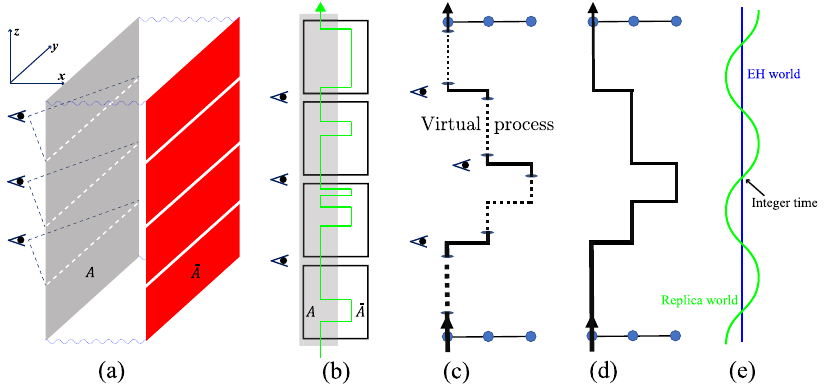
Fig. 3 | The equivalence principle of ES and energy spectrum. a The schematic diagram of the path integral of the reduced density matrix. The x/y/z axis repre- sents the direction of the J 0 bond/ J bond/imaginary time. The wavy lines mean the interactionsbetweensubsystem A andenvironment A .The A hasbeendividedinto severaldisconnectedreplicasalongtheimaginarytimeaxiswhileallthereplicasof A are connected in time, which is the same as the Fig. 1. The eyes observe the information of ES at the integer time point of β A which means we can only extract the information of ES on the connections of replicas. b The x − z plane view of ( a ). Thegraypartisthesubsystem A andthewhitepartistheenvironment A .Theblack plaquettes mean the replicas and the green line represents the worldline of a